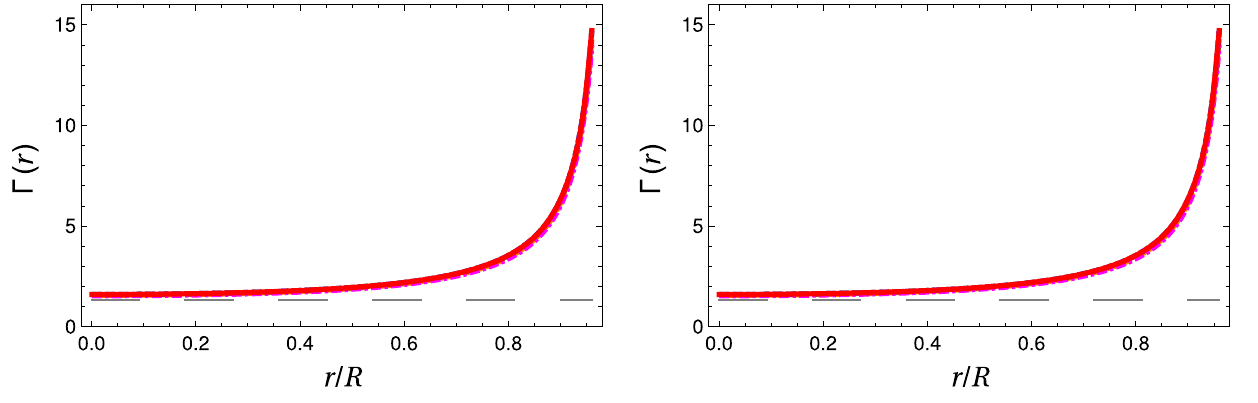
Fig. 5 Adiabatic index (cid:13) versus dimensionless radial coordinate r / R for the five plus five interior solutions obtained here. The horizontal dashed line corresponds to the Newtonian limit 4 / 3. Left: Solutions 1–5 corresponding to the case G (cid:5) ( r = 0 ) = − 0 . 0002 / km (Table 1). Shown are: (i) Solution 1 (solid red line), (ii) Solution 2 (short dashed